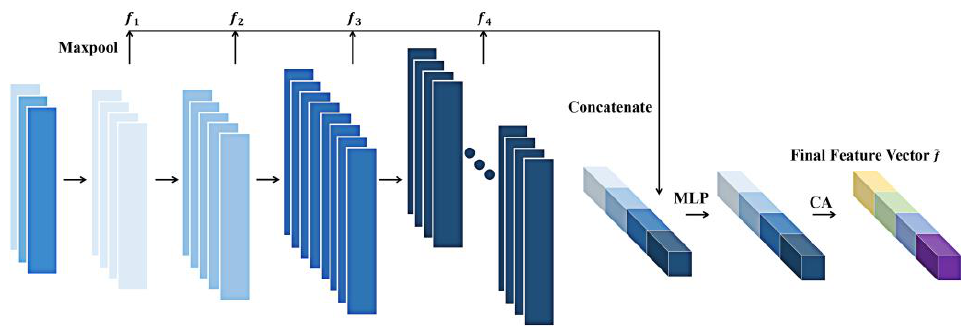
Figure 4. Structure of the proposed